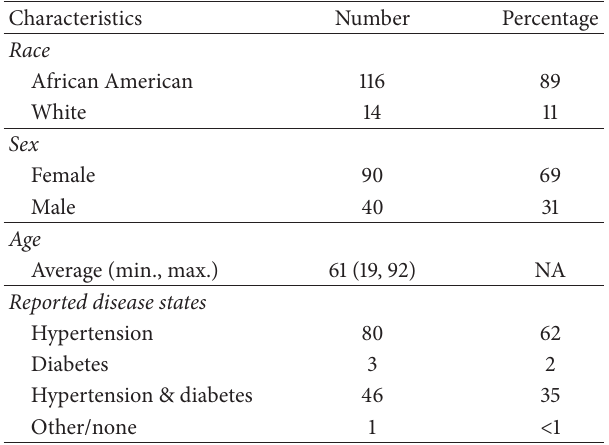
Table 1: Classification of overweight and obesity by BMI ∗ . Table 2: Characteristics of the patients in this study ( 𝑛 = 130